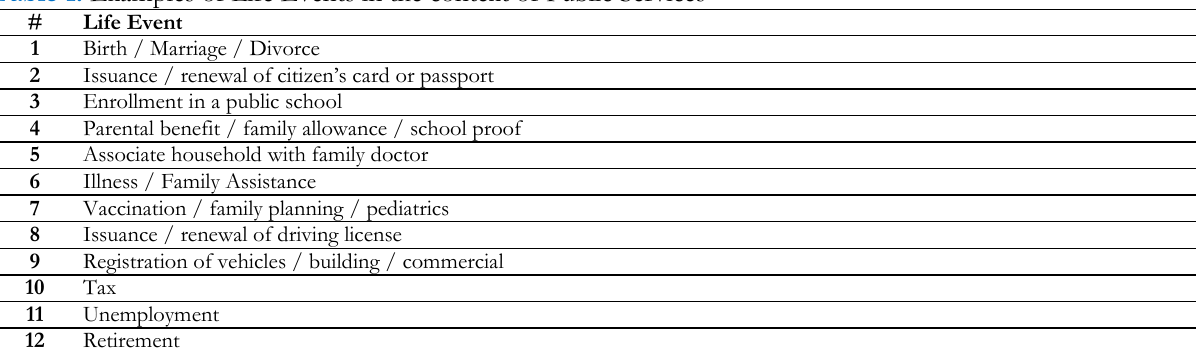
Table 1. Examples of Life Events in the context of Public